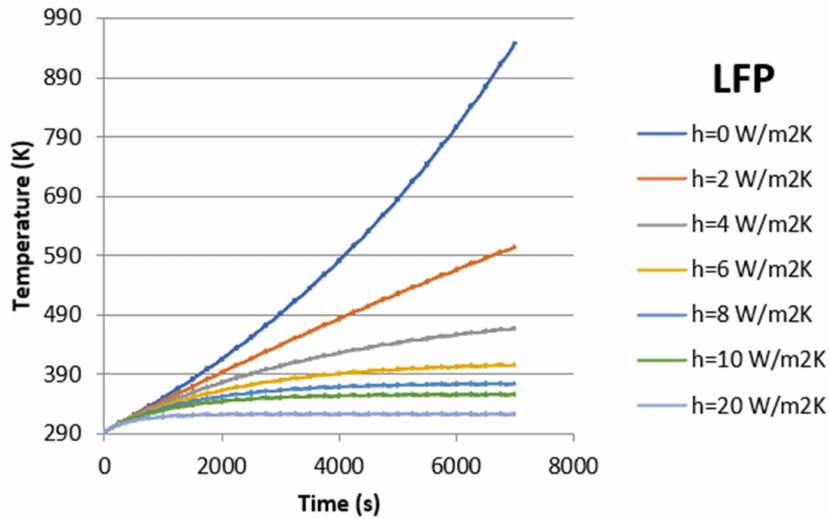
Figure 7. Temperature profile for an LFP cell in the absence of exothermic